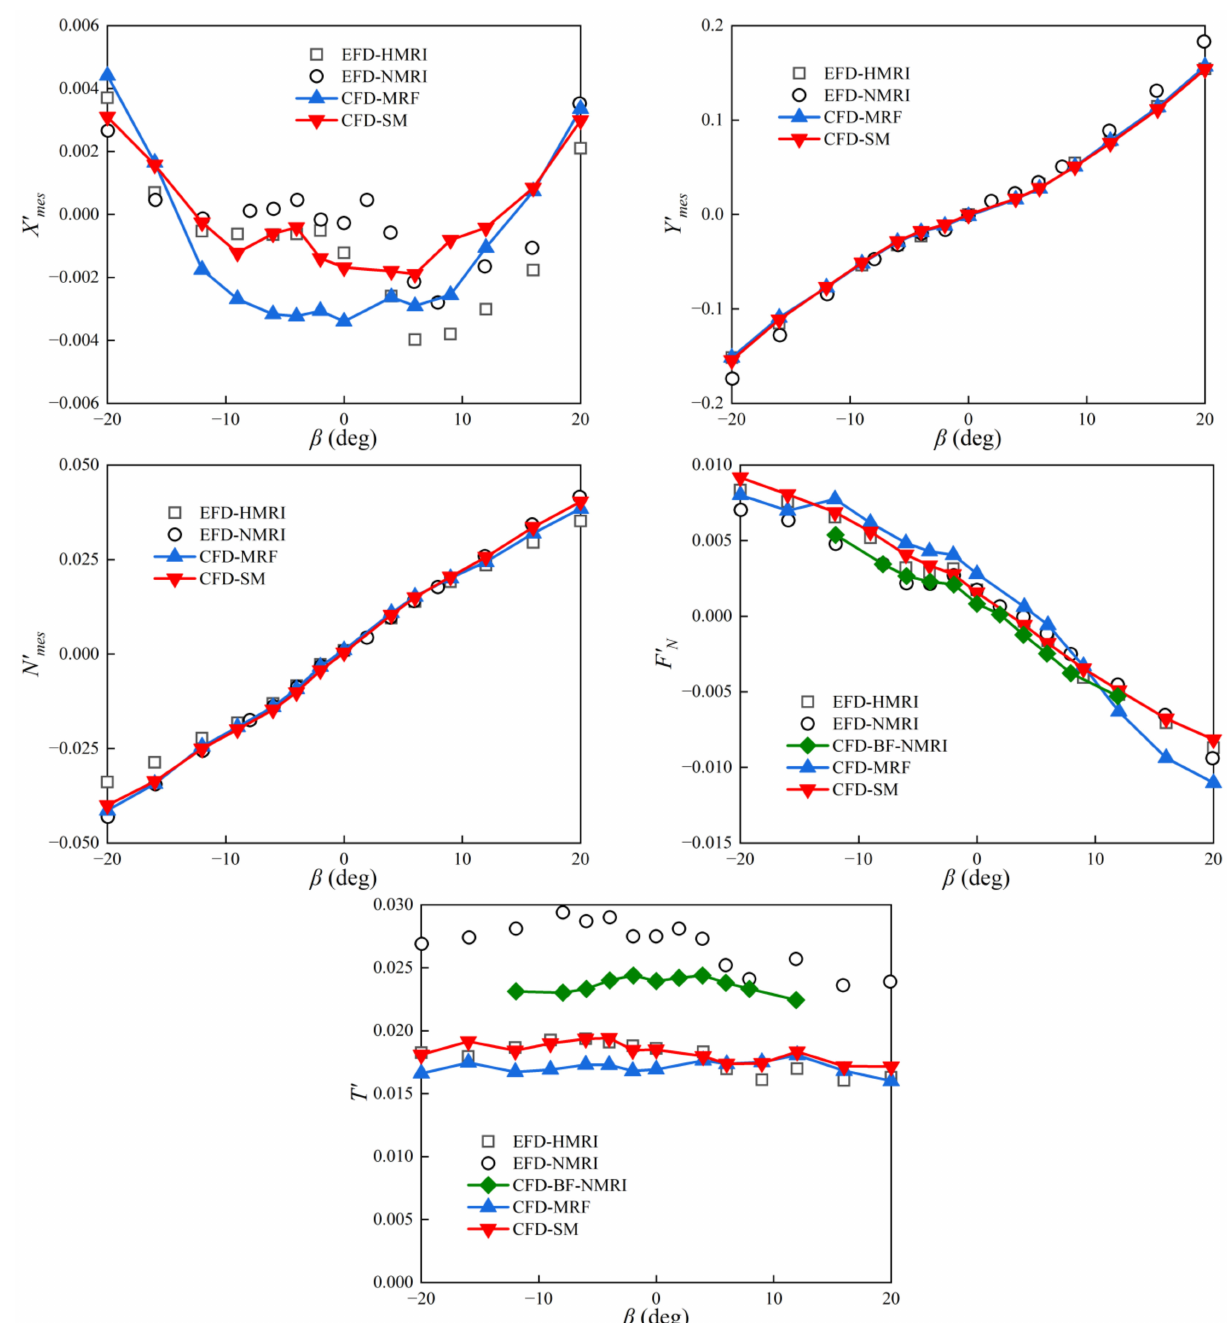
Figure 8. Hydrodynamic quantities in OTTs obtained from experiments and